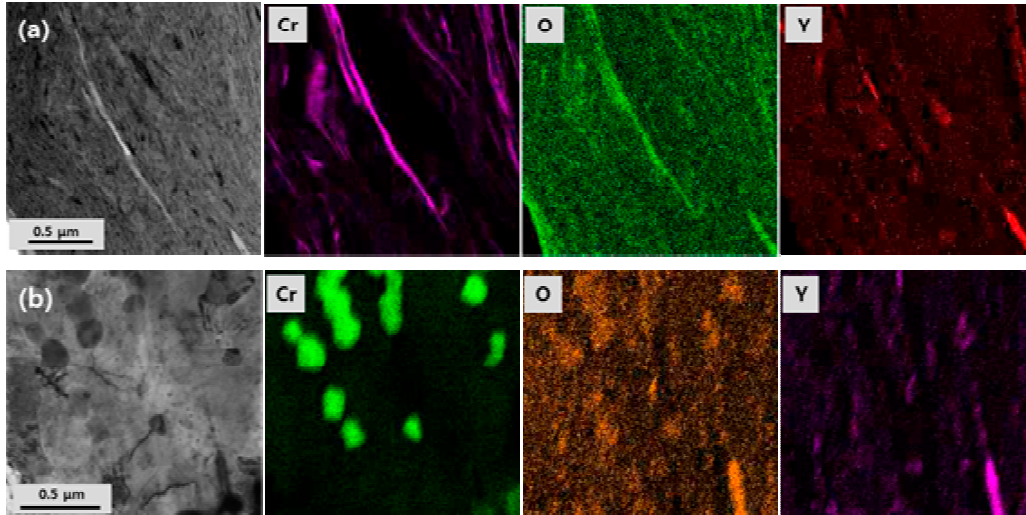
Figure 5. TEM/Energy Dispersive X-ray Spectroscopy (EDS) study results for the mechanically alloyed Fe-10Cr-5Y 2 O 3 powders after: ( a ) MA and ( b ) heat treatment at 900 °C.